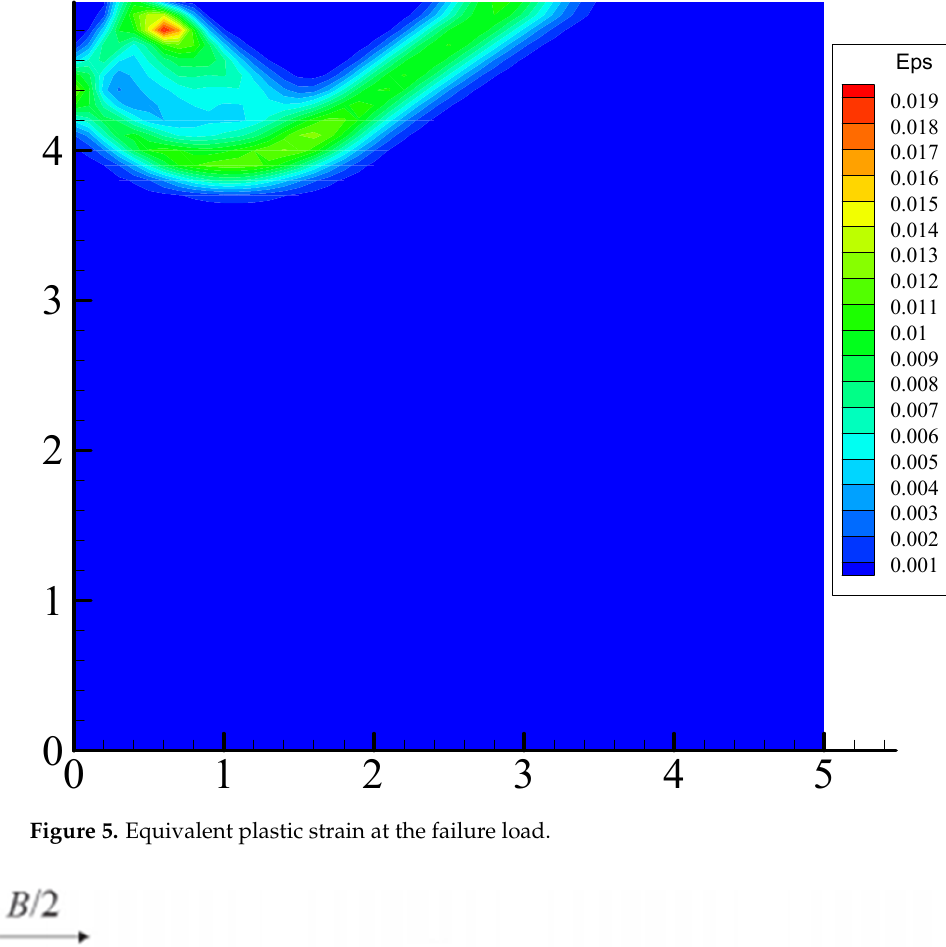
11 Figure 4. Pressure versus displacement. The limit loads obtained are